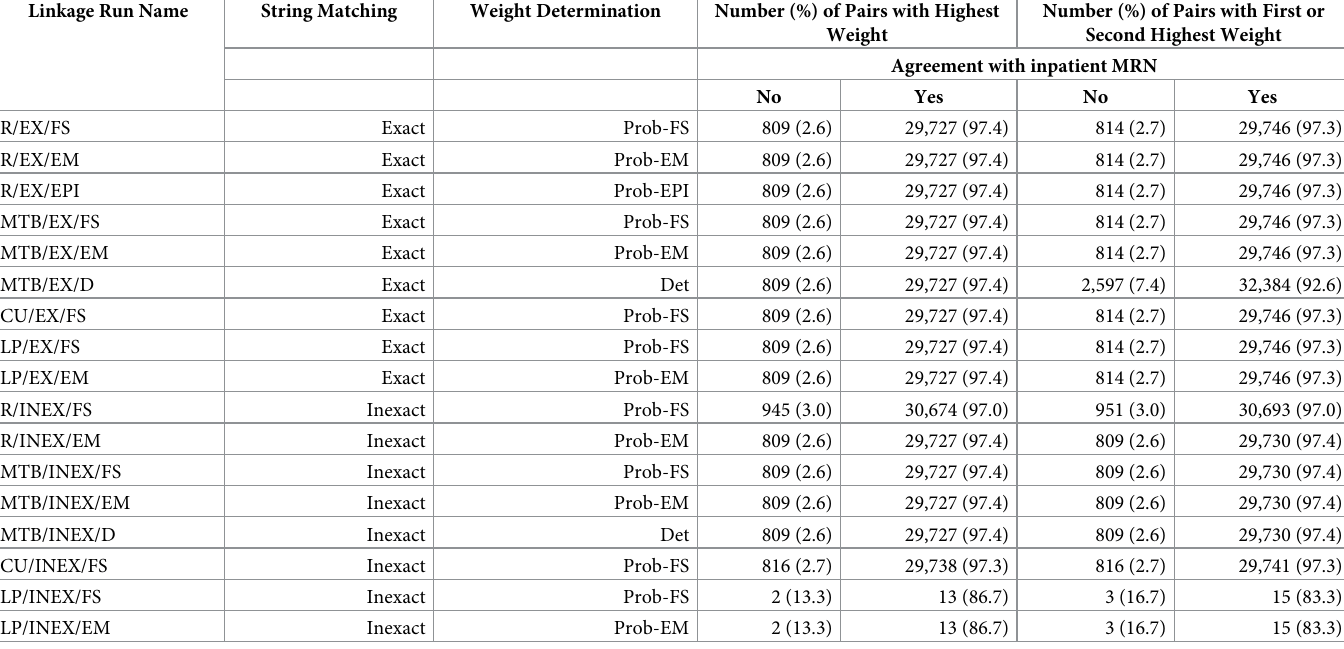
Table 4. Agreement with gold standard among records with the highest weights, blocking on